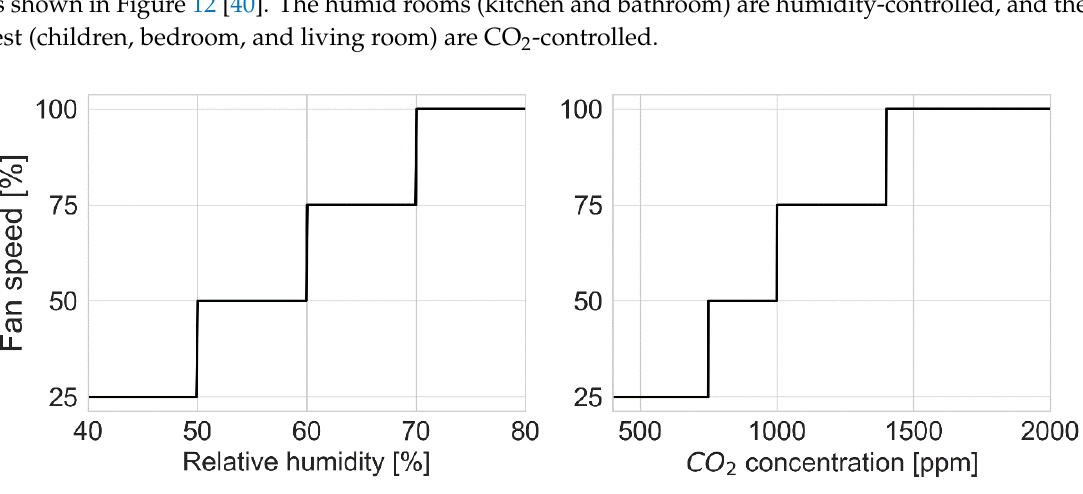
Figure 12. Fan speed in relationship to room relative humidity and CO 2 concentration.